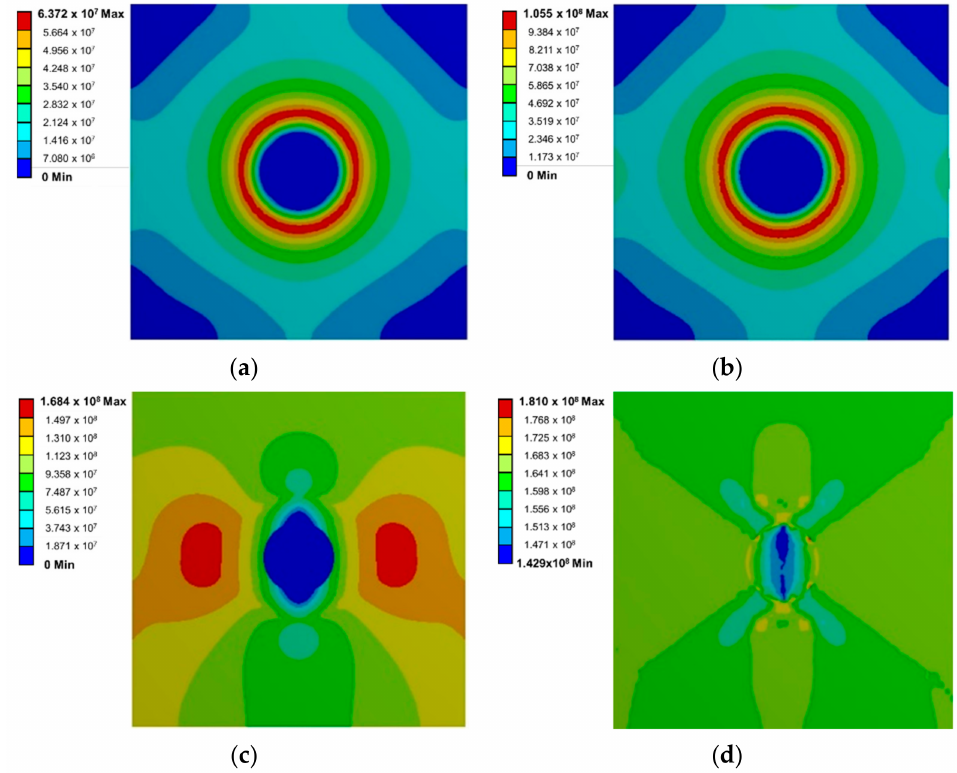
Figure 4. Stress distribution around the circular SiO 2 microparticle for ( a ) step number 10, ( b ) step number 20, ( c ) step number 40, and ( d ) step number